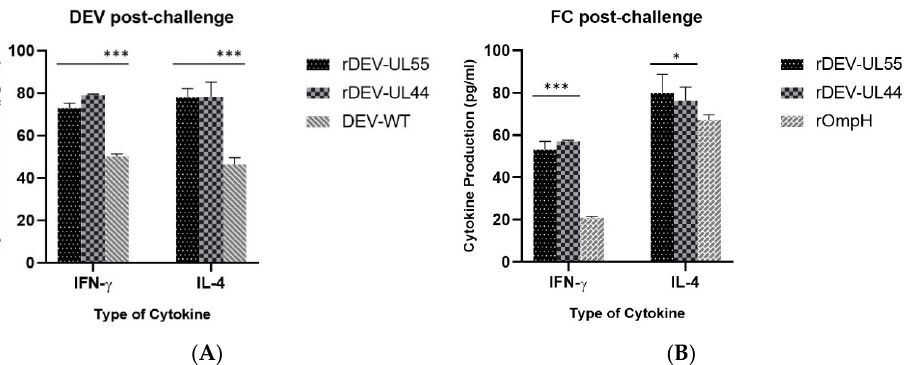
Figure 5. Cellular response to rDEV-UL55 and rDEV-UL44 post-challenge with DEV ( A ) or P. multocida ( B ). Serum IFN- γ and IL-4 cytokine levels in surviving ducks were analyzed at 7 days post-challenge. Statistically significant differences are indicated by (***) p < 0.001 and (*) p < 0.05 comparing the recombinant DEV ‐ OmpHs with the DEV ‐ WT or rOmpH group.